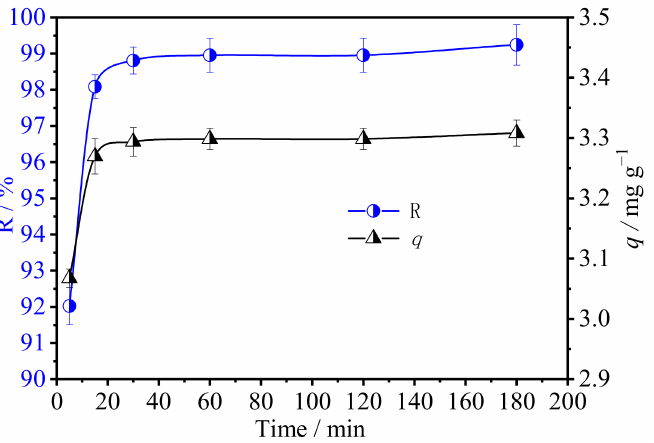
Figure 6. Effect of contact time on the adsorption of U(VI) by SAIEF (C 0 = 50 mg L − 1 , solid-liquid ratio = 0.15 g L − 1 , pH =